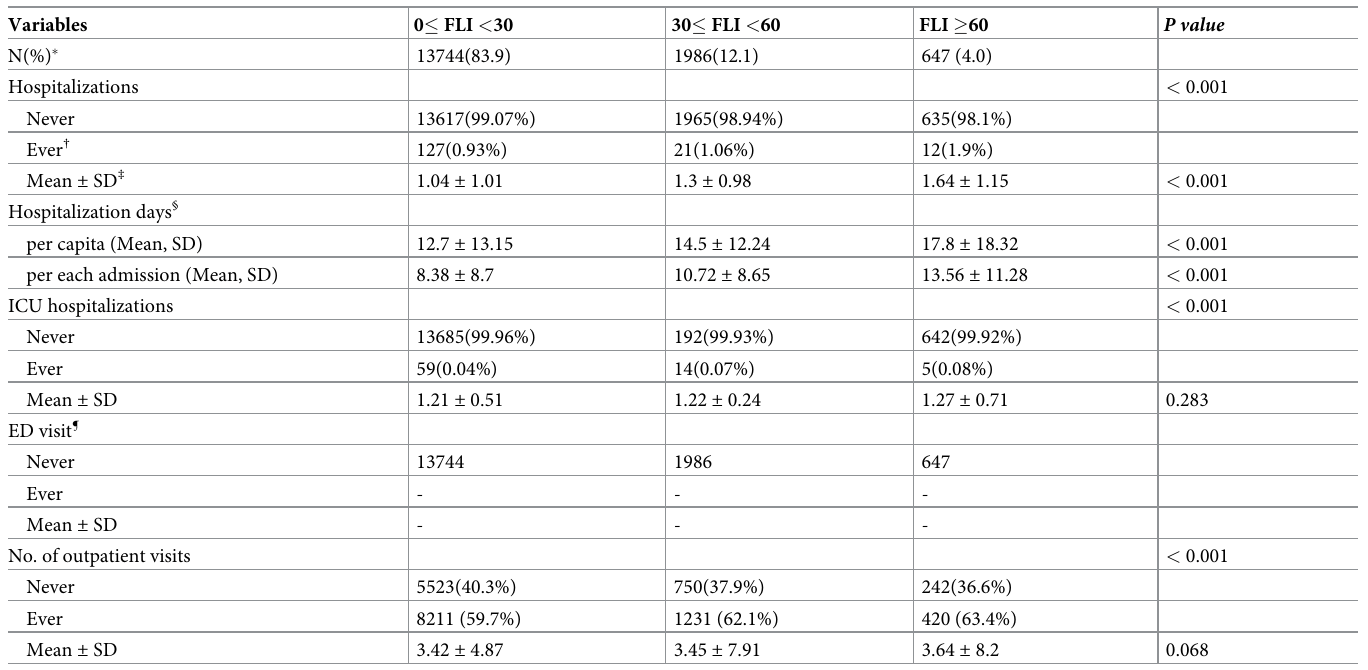
Table 4. Asthma-related healthcare use between FLI